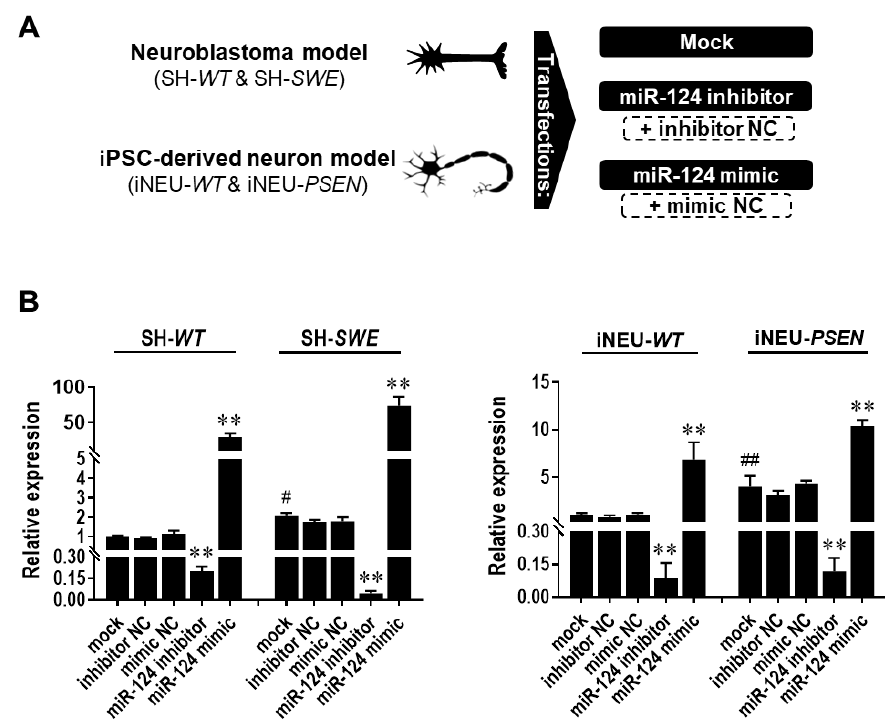
Figure 2. Expression levels of miR-124 in SH- WT /SH- SWE and iNEU- WT /iNEU- PSEN cells after transfection with the mock and with the miR-124 inhibitor and mimic. Cells were obtained, differ- entiated, and transfected, as detailed in Material and Methods. ( A ) Schematic representation of the miR-124 modulation with miR-124 inhibitor and/or mimic, as well as with scramble (respective negative controls—NC). ( B ) miR-124 expression levels before and after its modulation in SH- WT /SH- SWE and iNEU- WT /iNEU- PSEN cells. Results are mean ± SEM fold change from at least three independent experiments. ** p < 0.01 vs. respective mock control cells, one-way ANOVA with Bonferroni post-hoc test; # p < 0.05 and ## p < 0.01, between WT and AD mock controls, two-tailed student’s t -test. miR, miRNA; NC, negative control; SH- WT , human SH-SY5Y wild-type neurons; SH- SWE , human SH-SY5Y expressing the APP695 Swedish mutant protein; iNEU- WT , iNeurons derived from induced pluripotent stem cells (iPSCs) generated from a healthy control; iNEU- PSEN , iNeurons from iPSCs generated from a patient carrying the PSEN1 ∆ E9